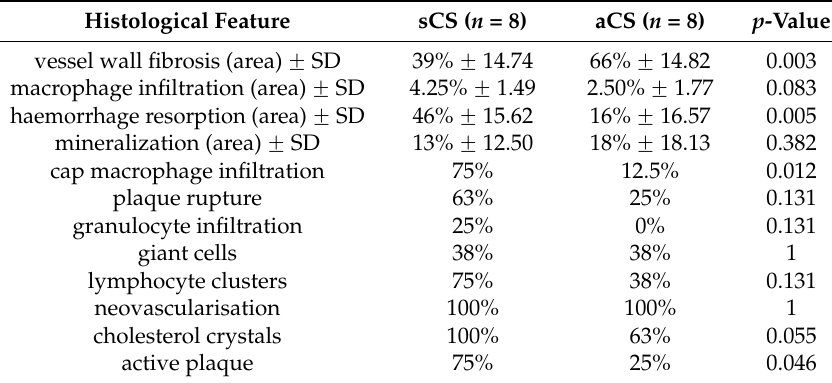
Table 2. Histological analysis of CS.